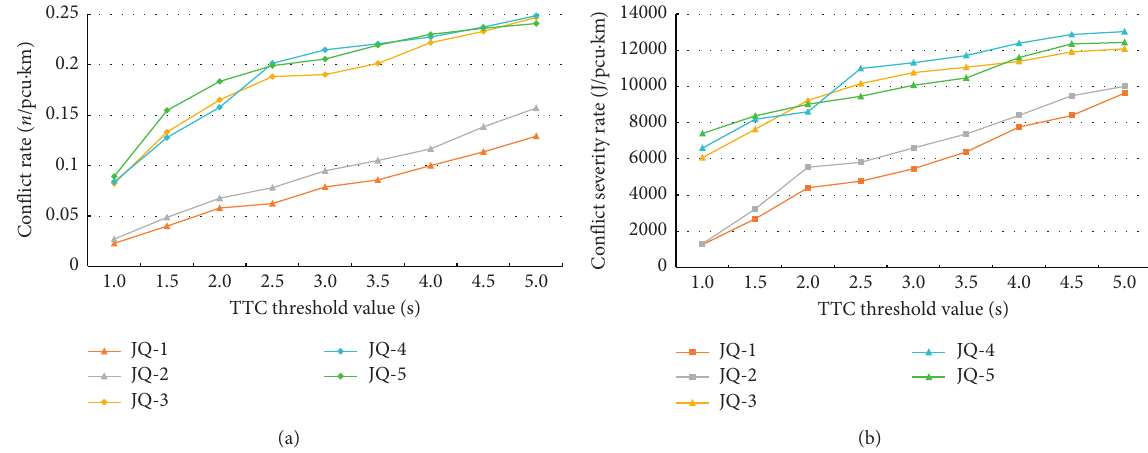
Figure 9: Conflict rates and severity rates of all sections under different TTC threshold values.